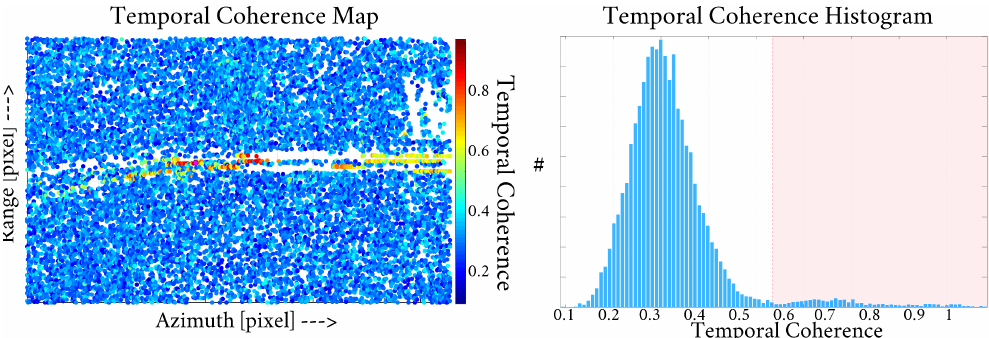
Figure 6. Selecting “informative” points by thresholding on temporal coherence. The thresholding is based on the bimodal-distribution assumption. Otsu’s thresholding method [25] is applied to get the threshold